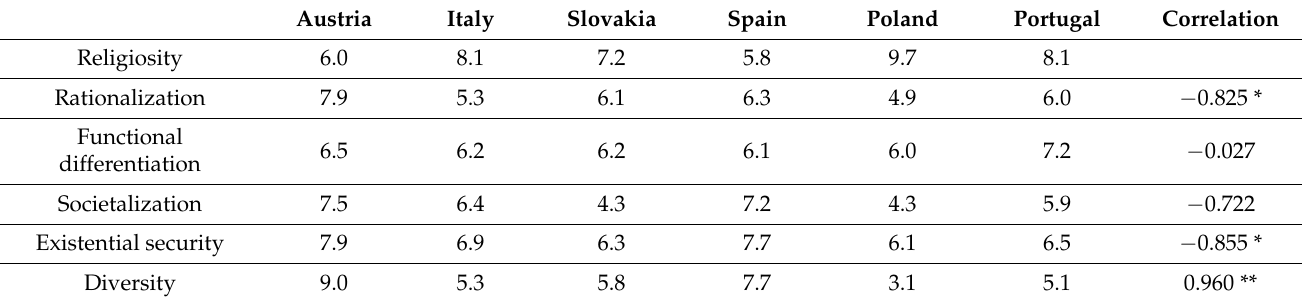
Table 1. Arithmetic average of each variable (dependent and independent) and their correlation.